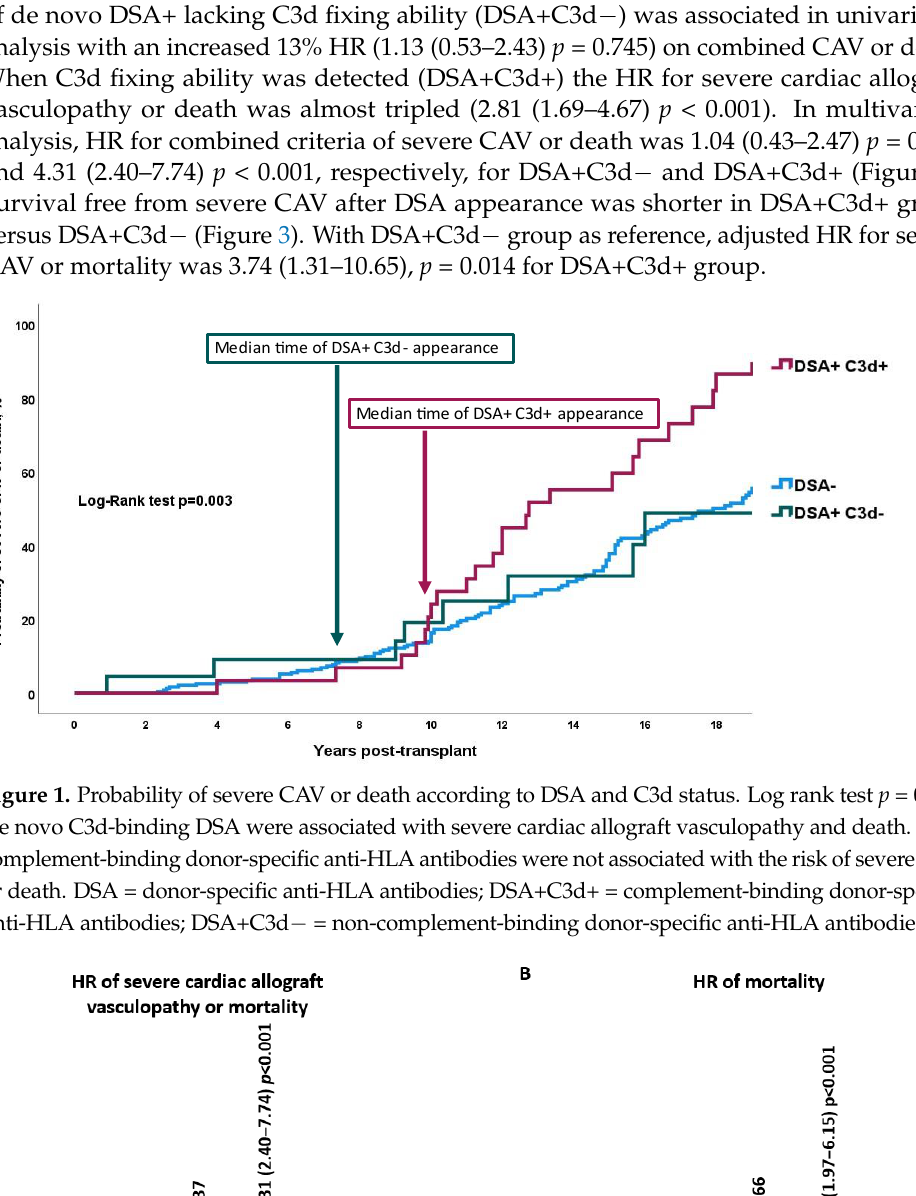
Figure 3. Adjusted Cox regression survival curves. Adjustment with recipient sex, recipient age, CMV status at transplantation, number of cellular rejection episodes ≥ grade 2, total number of mis- matches, creatinine at time of coronary angiography, and ejection fraction at time of coronary angi- ography. CAV = cardiac allograft vasculopathy; DSA = donor specific antibodies. 3.4. Impact of DSA and C3d Binding Ability on Long-Term Mortality Mean survival time was 21.9, 20.3, and 16.4 years for DSA − , DSA+C3d − , and DSA+C3d+, respectively, p = 0.027 by the log-rank test (Figure 4). Presence of de novo DSA+C3d − and DSA+C3d+ was associated in univariable analysis with a hazard ratio of 1.32 (0.61 – 2.83) p = 0.481 and 2.74 (1.67 – 4.49) p < 0.001, respectively of combined criteria of severe cardiac allograft vasculopathy or death. In multivariate analysis, HR for mortality was 1.08 (0.45 – 2.61) p = 0.866 and 3.48 (1.97 – 6.15) p < 0.001 for DSA+C3d − and DSA+C3d+, respectively (Figure 2). Survival after DSA appearance was shorter in DSA+C3d+ group